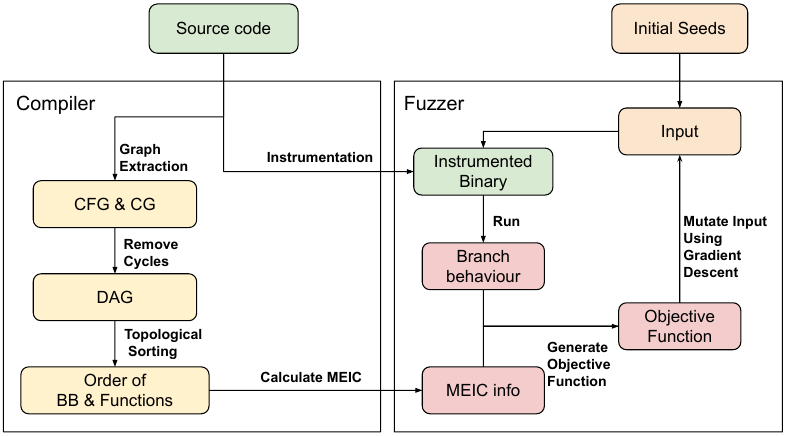
Figure 2. Overview of MaxAFL. MaxAFL consists of two main component: Compiler and Fuzzer. Compiler performs static analysis for calculating MEIC and binary instrumentation. Fuzzer executes instrumented binary repeatedly using gradient-based